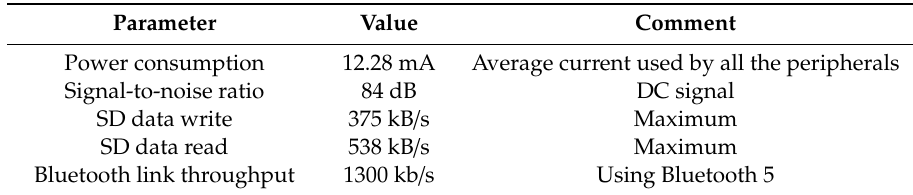
Table 3. System benchmarks.